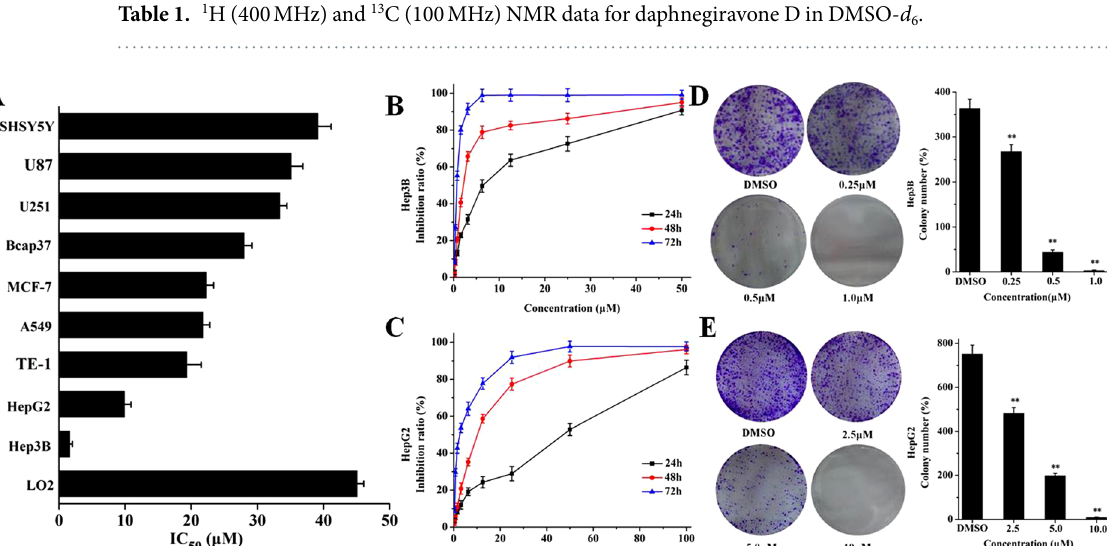
3 Scientific RepoRts | 7: 5736 | DOI:10.1038/s41598-017-05955-0